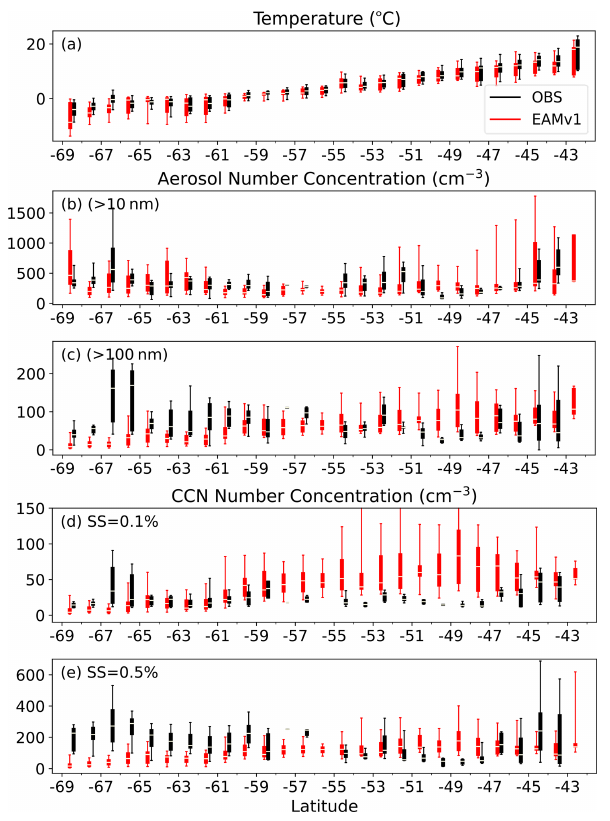
Figure 16. Percentiles of (a) air temperature, (b) aerosol number concentration for diameters > 10nm, (c) aerosol number concen- tration for diameters > 100nm, (d) CCN number concentration for SS = 0 . 1%, and (e) CCN number concentration for SS = 0 . 5% for all ship tracks in MARCUS binned by 1 ◦ latitude bins.